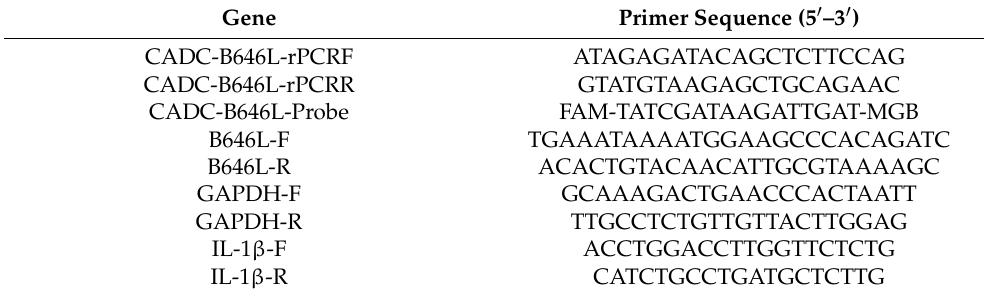
Table 1. Primer sequences were used in this study for PCR and real-time PCR in pigs. Gene Primer Sequence (5 (cid:48) –3 (cid:48)